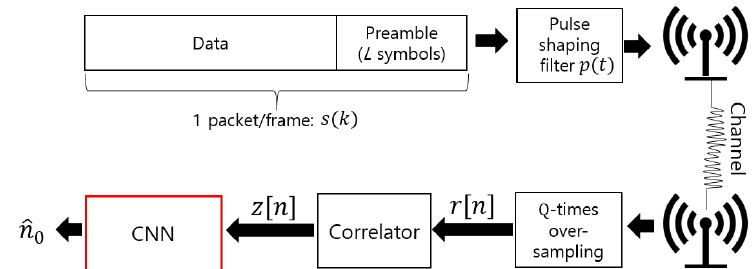
Figure 4. Overall block diagram of the proposed convolutional neural network (CNN)-based frame